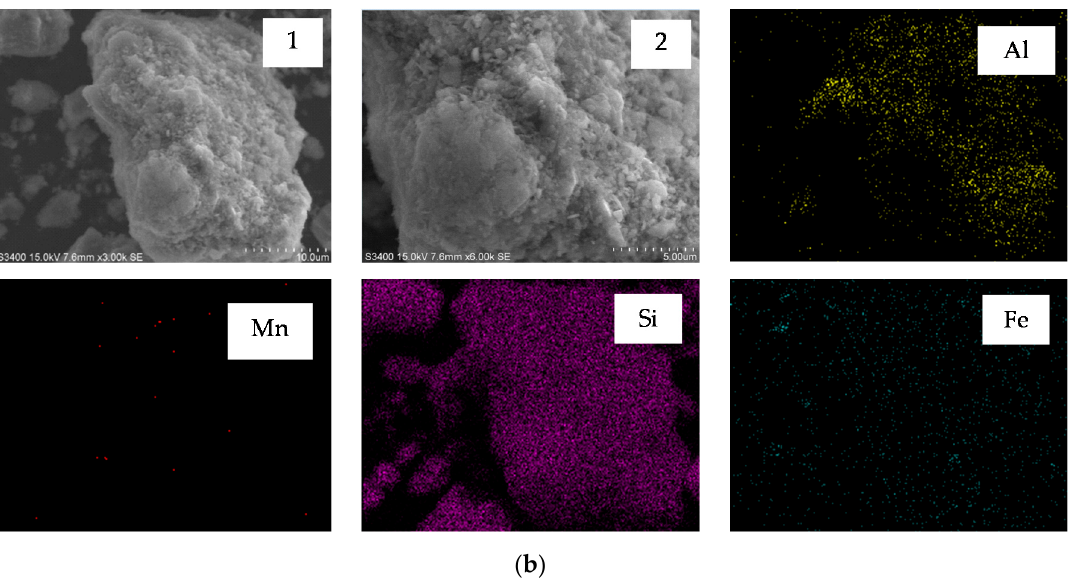
Figure 6. Scanning electron microscope (SEM) images and energy dispersive X-ray spectrometry (EDS) element mapping of ( a ) semi-oxidized manganese ore; and ( b ) leaching residue.